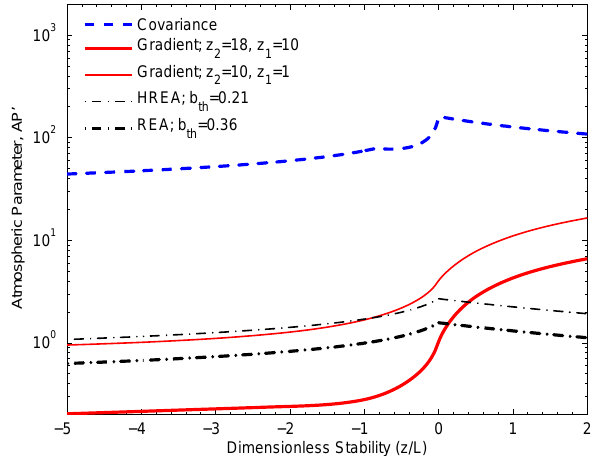
Fig. 3. Comparison of the required sensor resolution as a function of stability for three flux measurement methods as indicated by the redefined atmospheric parameter, AP 0 x . Wind speed is 8ms − 1 and instrument height is 18m for covariance and (H)REA methods. Two cases are shown for the gradient method: for the gradient method, a typical ocean, ship-based installation with z 2 = 18m and z 1 = 10m, and a lake or land-based installation with z 2 = 10m and z 1 = 1m, are